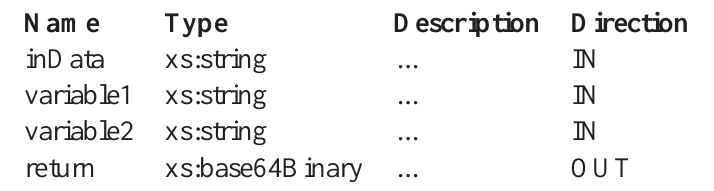
Table 2: Description of the ScatterPlot method.